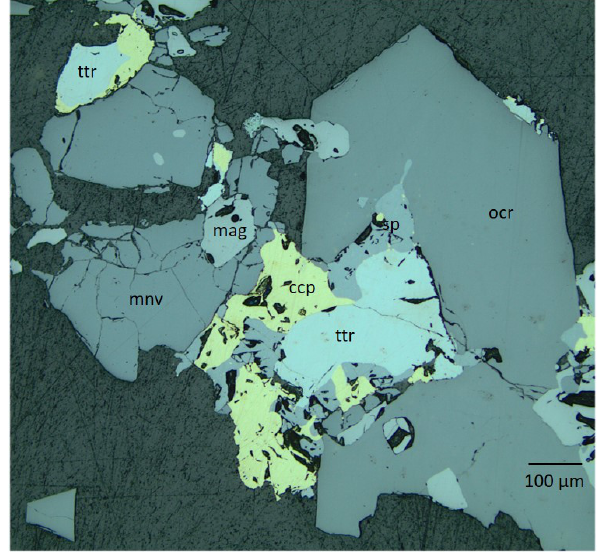
Figure 2. Reflected-light microscope picture illustrating the textural relations between the sulfides and oxides. Blue-filtered incandes- cent light. Abbreviations: mnv – monteneveite; mag – magnetite; ocr – oxycalcioroméite; ttr – tetrahedrite-(Fe); sp – sphalerite; ccp – chalcopyrite. Sample GEO-NRM catalogue no. HS3903.